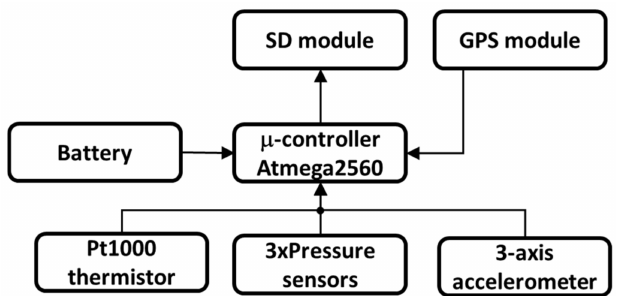
Figure 1. Scheme of the monitoring unit.